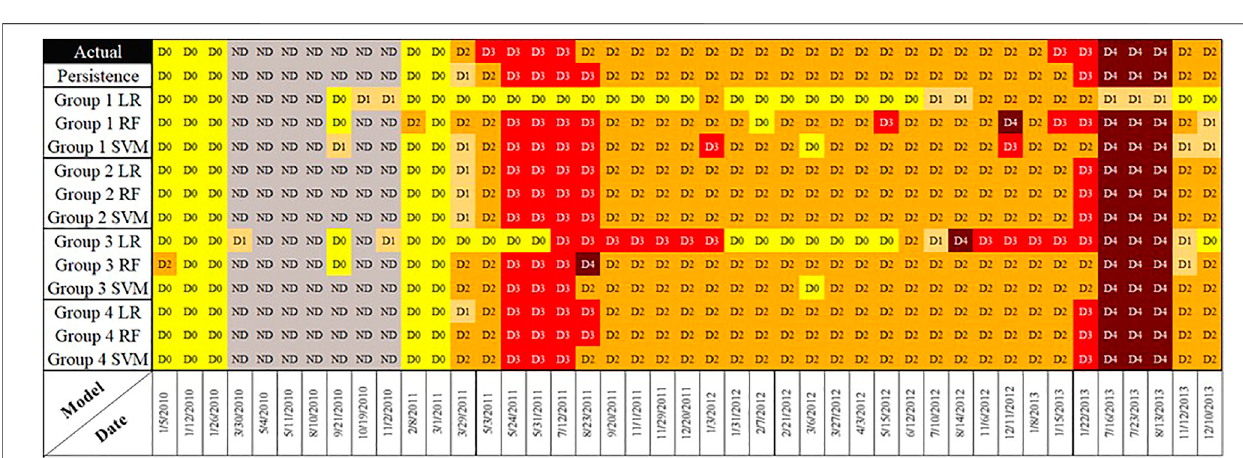
Frontiers in Big Data |